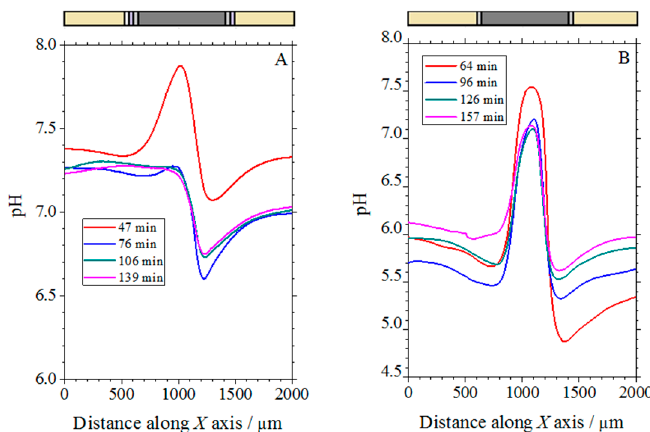
Figure 10. Line scans recorded with the pH sensitive antimony microelectrode above the cut edge of galvanized steel samples immersed in 1 mM NaCl solution. ( A ) Complete coil-coated system with organic layers of different thickness at each side (corresponding to sketch #1 in Figure 1C); ( B ) coil-coating system after removing the organic coatings at each side (corresponding to sketch #2 in Figure 1C). The lines were recorded from the left to the